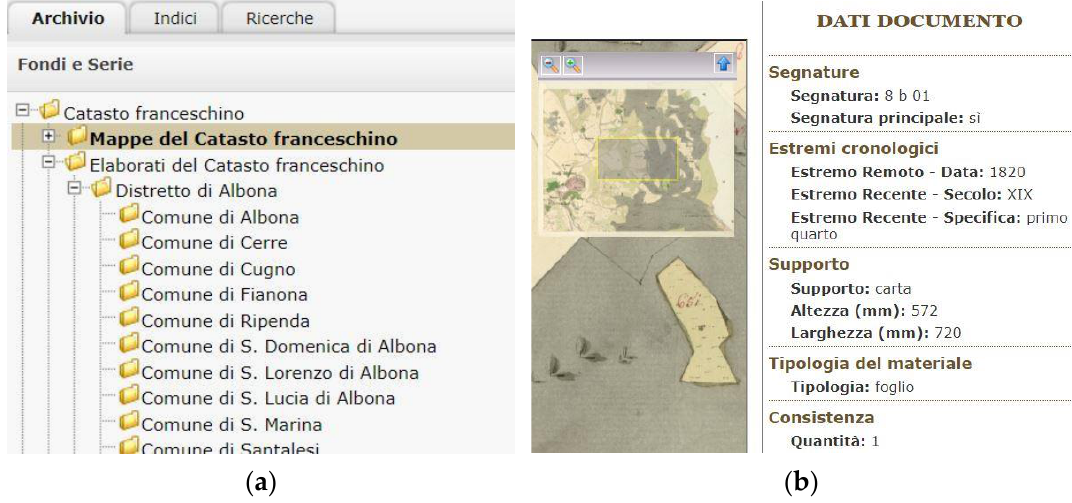
Figure 7. Cadastral documentation of the Franciscan Cadastre in archive in Trieste: ( a ) hierarchical structure in the catalog of Trieste and ( b ) cadastral map sheet described by metadata elements [58].